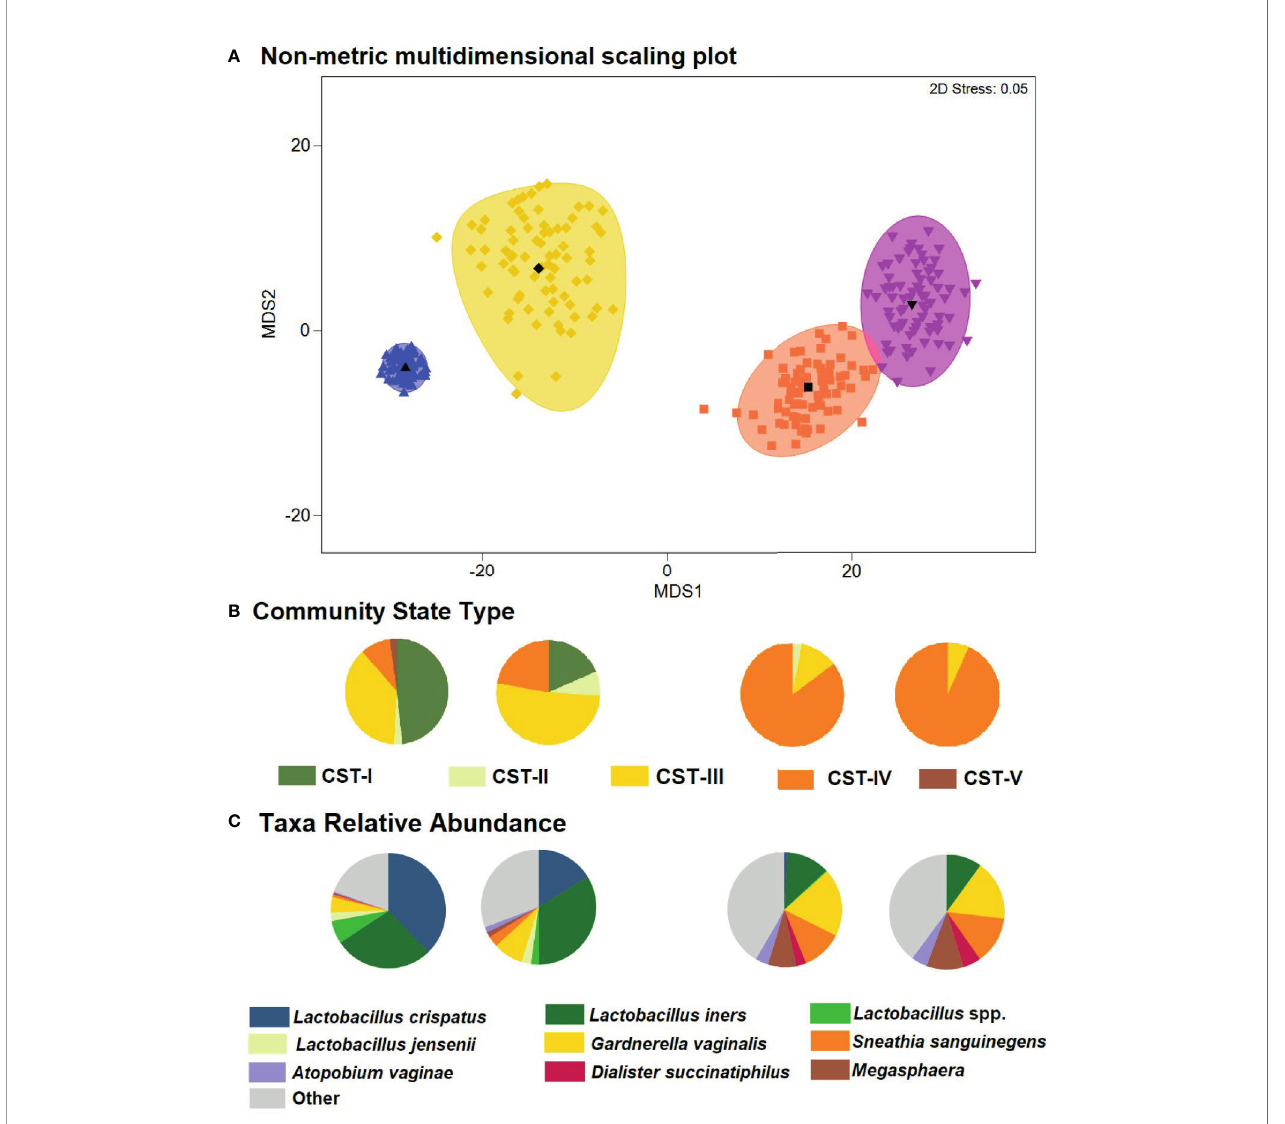
FIGURE 3 | Non-metric dimensional scaling plot for each of the four outcome states for Bacterial vaginosis (BV) or sexually transmitted infection (STI) and distribution of Community State Type (CST) and taxa relative abundance. (A) The four different colors represent the four outcome states for Bacterial vaginosis and sexually transmitted infection. STI is a composite of infection with any of C. trachomatis, N. gonorrhoeae, T. vaginalis. Blue = negative for BV and all STIs; yellow = STI positive, BV negative; orange = BV positive, STI negative; pink = both STI and BV positive. Each colored mark indicates one of 100 bootstrappings of the dataset. The matching shaded area represents the 95% coverage. The black symbol at the center of each colored shape represents the average centroid of the 100 bootstraps. (B) Pie charts below the non-metric dimensional scaling plot show the distribution of CST, aligned to outcome states for BV and STI (N=431 individuals represented). (C) Pie charts below the non-metric dimensional scaling plot show the distribution of mean relative abundance of taxa identi fi ed through stability selection in association with BV and STI (N=431 individuals